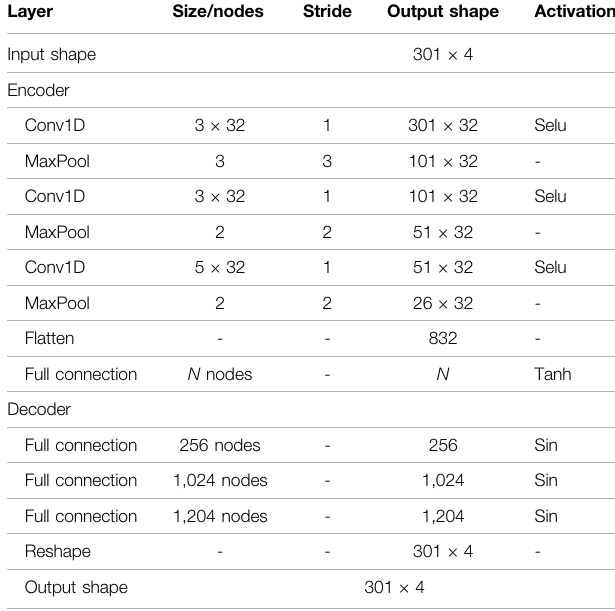
TABLE 1 | The detailed architecture of the 1D-CAE